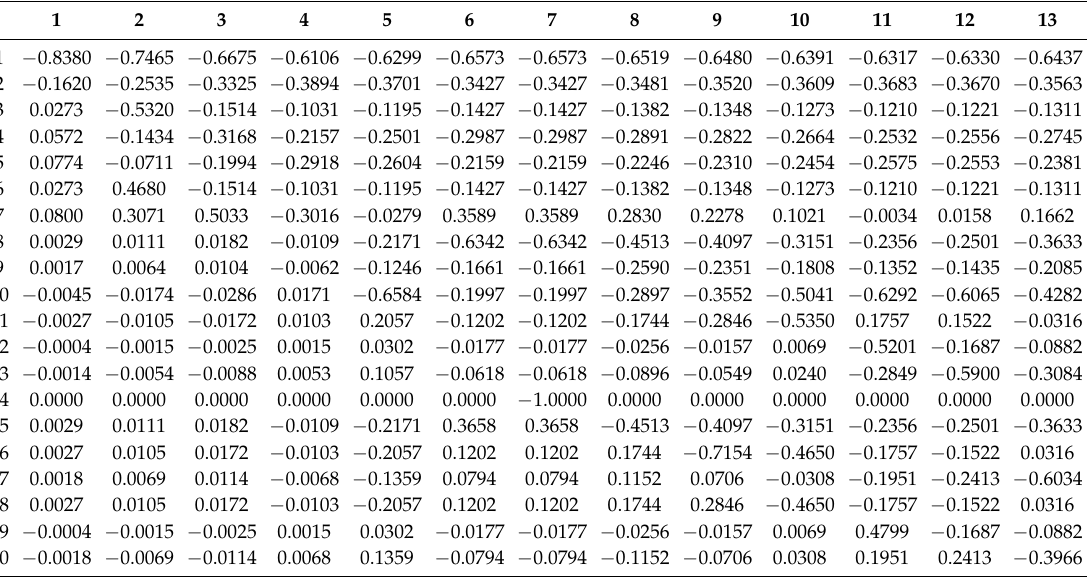
Table 1. Matrix A in a 14 buses system.